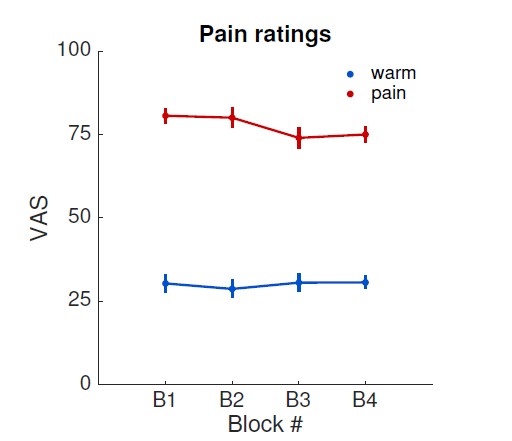
Intensity ratings after each fMRI block.